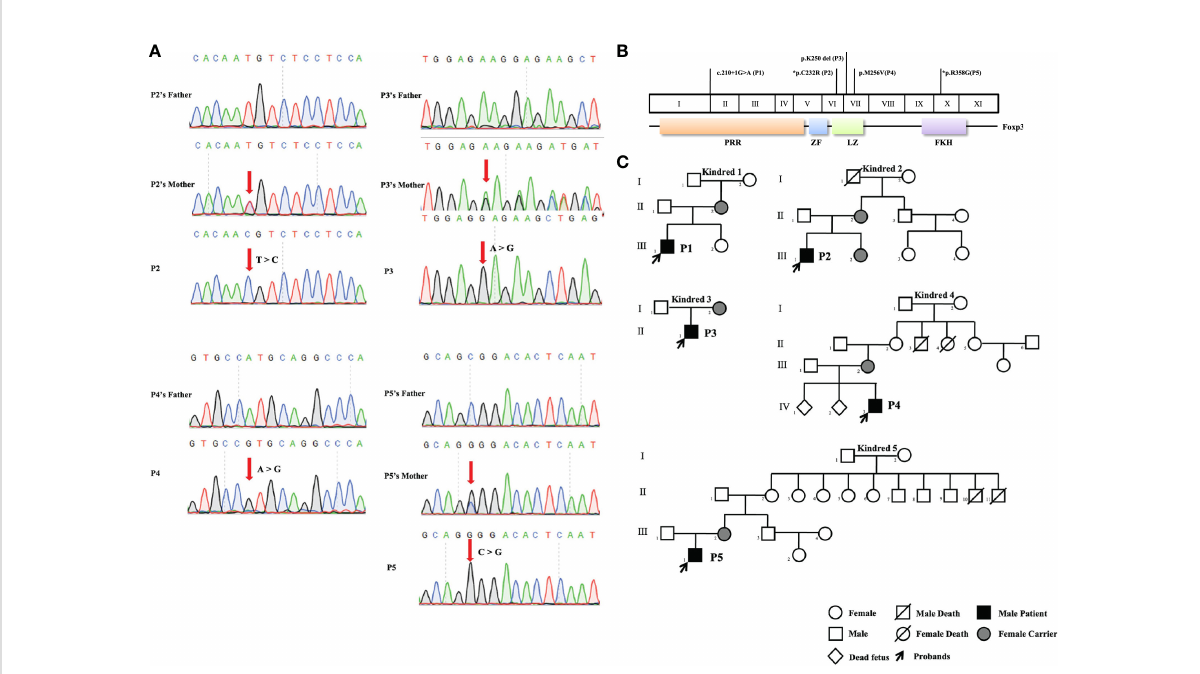
FIGURE 1 Pedigrees and pathogenic FOXP3 mutations of the fi ve patients. (A) Sanger sequencing con fi rmed the hemizygous FOXP3 mutations of the patients. The red arrows indicate the locations of mutations. (B) The FOXP3 coding region is shown, with the pathogenic mutations carried by the fi ve patients in this study. *Refers to novel mutations. The other mutations have been previously reported. (C) Pedigrees of the fi ve families with FOXP3 mutations. Each family is designated by a number (1 to 5). Black indicates patients, and the probands are indicated by